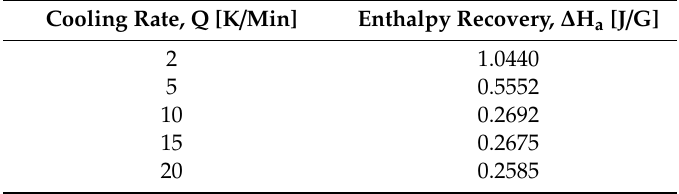
Table 3. The enthalpy recovery (∆H a ) of PNIPA versus the different thermal history, cooling rate (q). Cooling Rate, Q [K/Min]